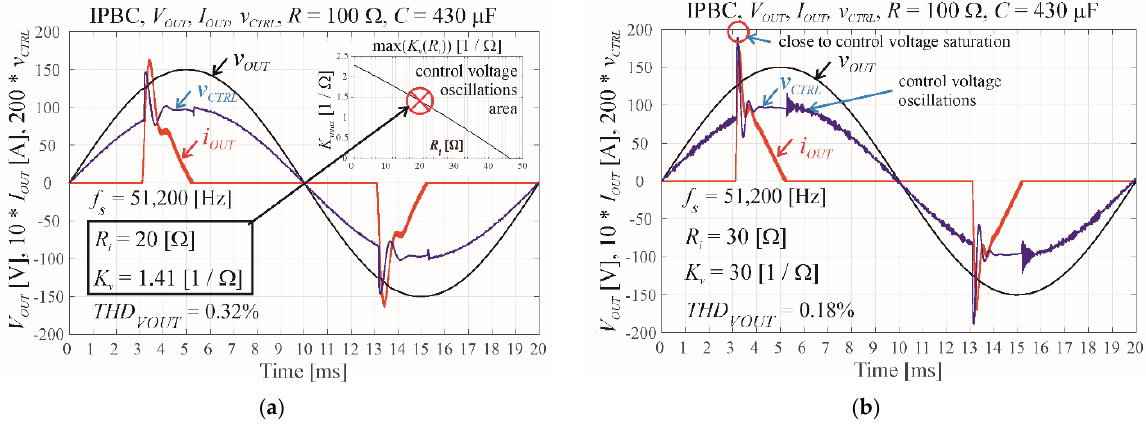
Figure 6. The border values of the gains ( a ) and the gains over the border values ( b ) of the output voltage, which resulted in a control voltage saturation for the rectifier RC load ( f s = 51,200 Hz, C F = 50 μ F, L F = 1 mH, R LF = 1 Ω , and M = 0.5, load: R = 100 Ω and C = 430 μ F).